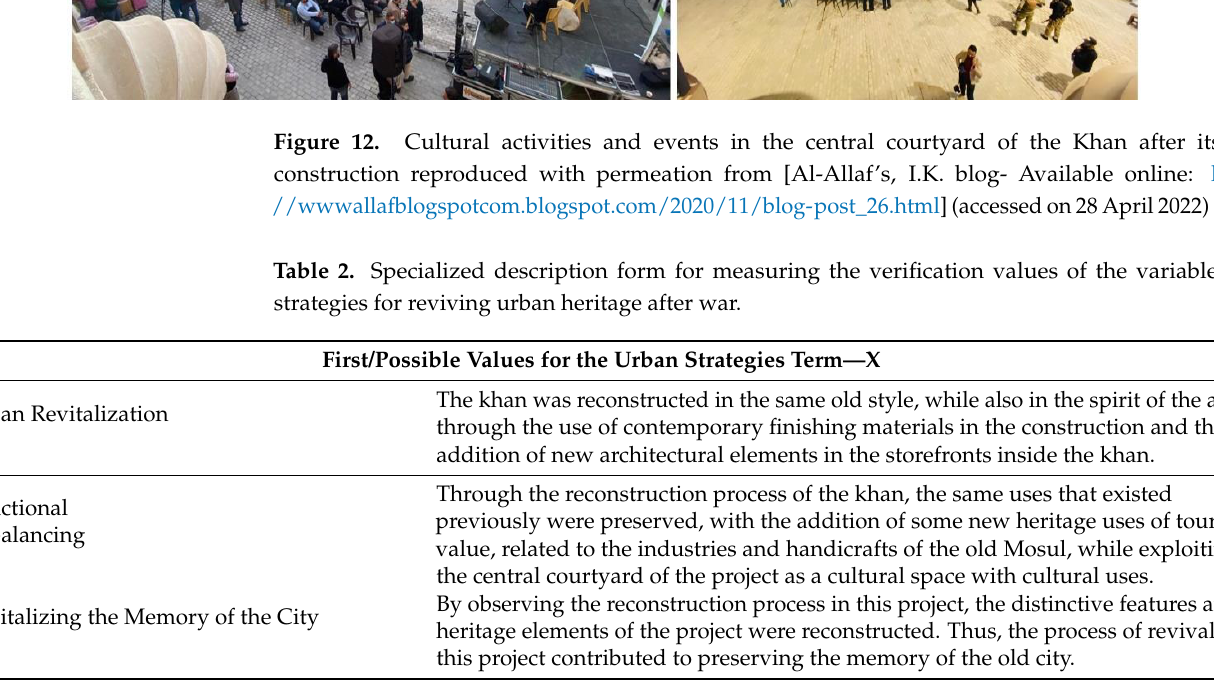
Figure 12. Cultural activities and events in the central courtyard of the Khan after its reconstruction reproduced with permeation from [Al-Allaf ’ s, I.K. blog- Available online: http://wwwallafblog- spotcom.blogspot.com/2020/11/blog-post_26.html] (accessed on 28 April 2022) [29].